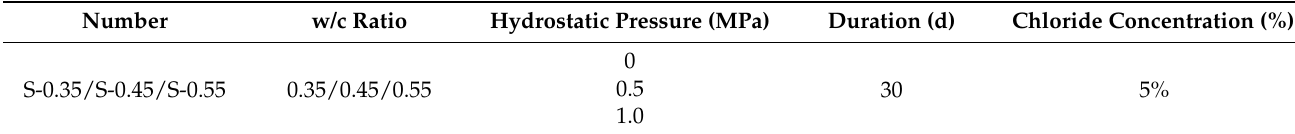
Table 7. External environment parameters of the